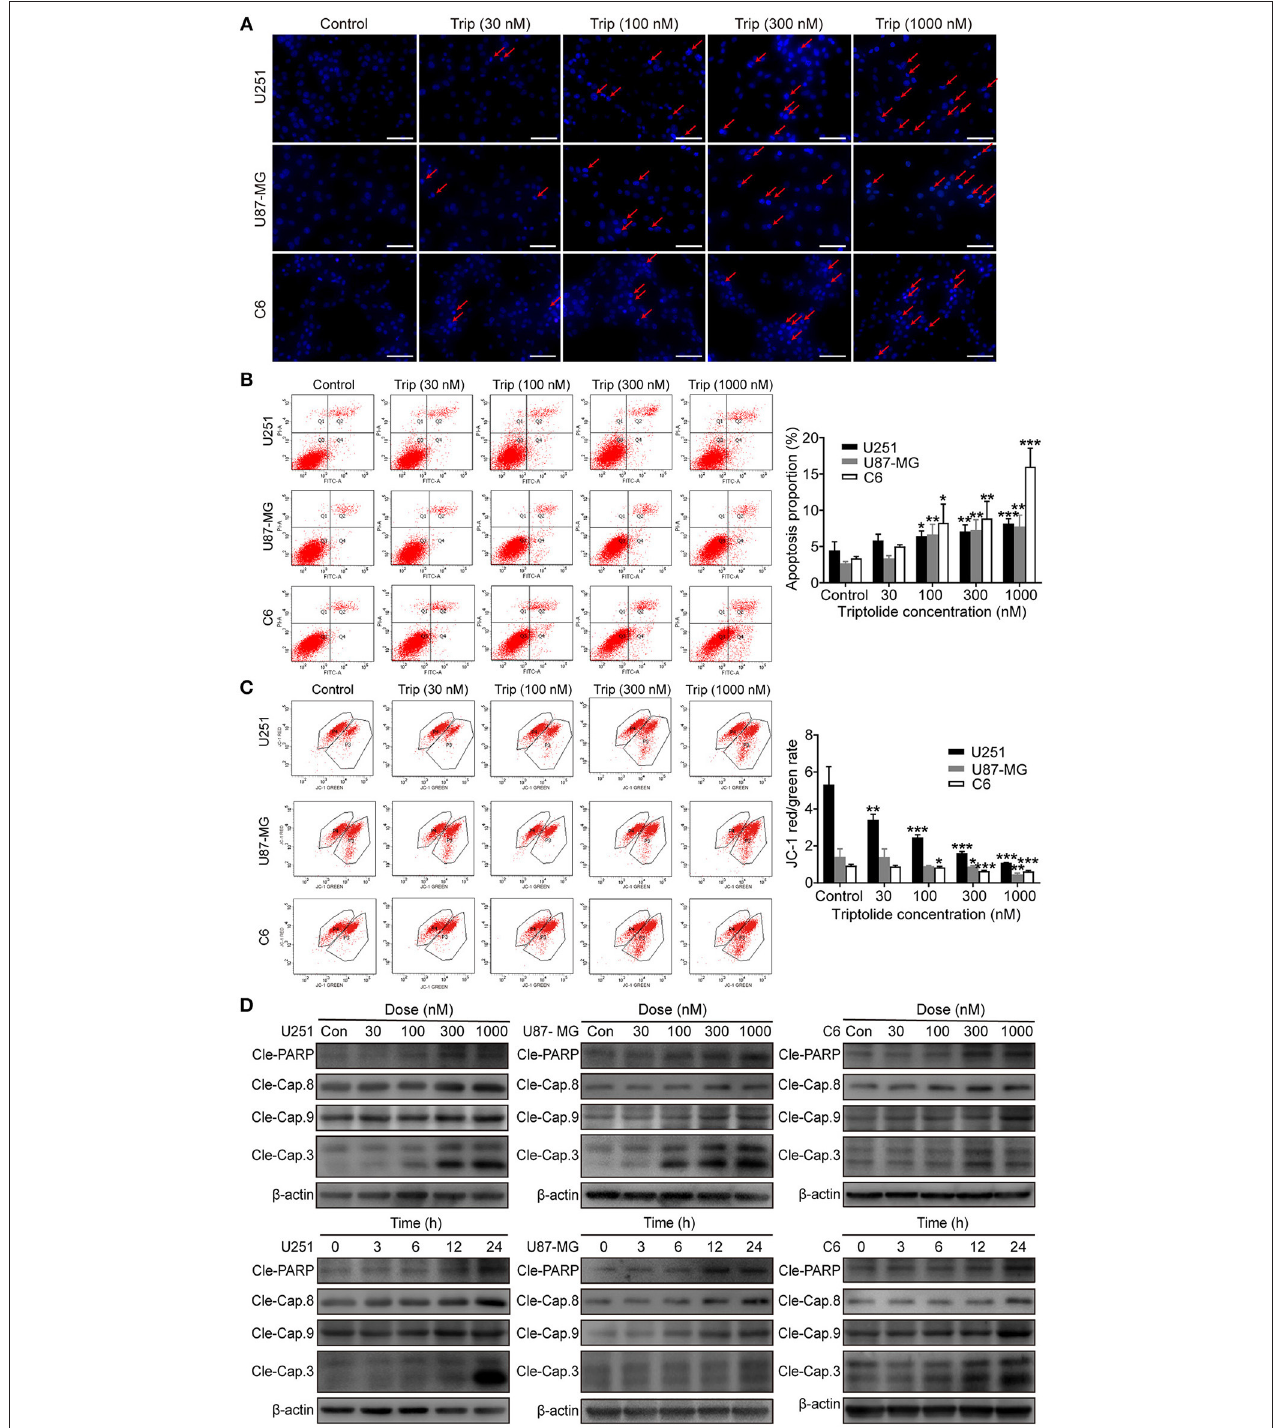
FIGURE 2 | Triptolide induced apoptosis in glioma cells. U251, U87-MG, and C6 cells were treated with the indicated concentrations of triptolide or vehicle for 24h. (A) Cells were fixed and stained with Hoechst 33342 and observed under a fluorescence microscope. (B) Apoptosis was analyzed by FACS using an Annexin V-FITC/PI cell apoptosis kit. Representative results from 3 independent experiments are presented. The data are presented as the means ± SD ( n = 3). ( C) MMP was assessed by FACS based on fluorescent mitochondria. The data are presented as the means ± SD ( n = 3). ( D) Cells were treated with the indicated concentrations of triptolide for 24h or incubated with triptolide (300nM) for different durations. Whole-cell lysates were separated by SDS-PAGE, and then, immunoblotting was performed using the indicated antibodies. * P < 0.05, ** P < 0.01, *** P < 0.001, significantly different compared with the untreated control group.